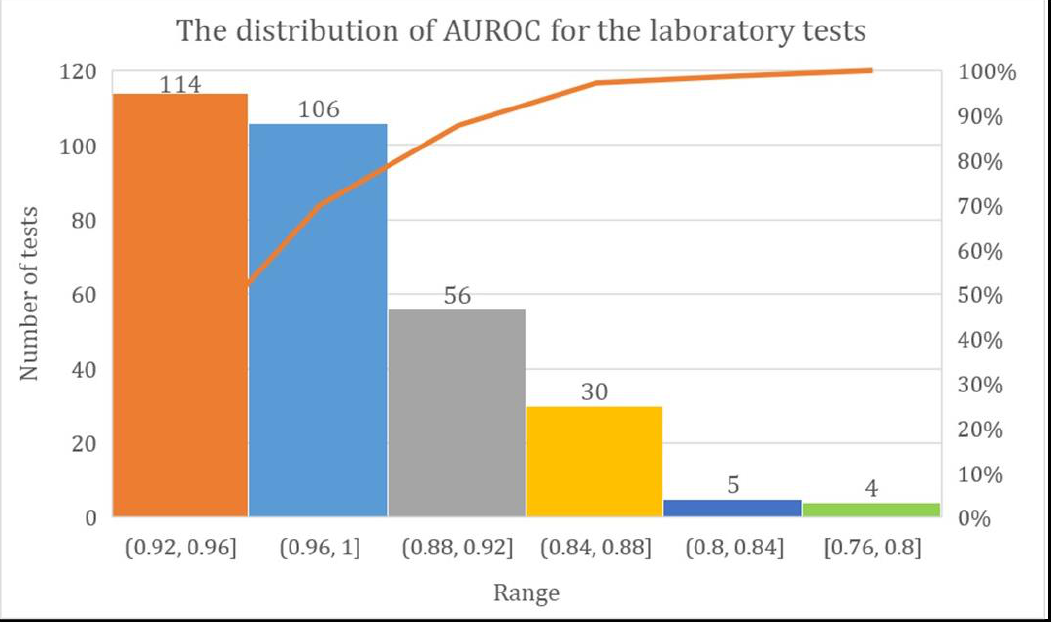
Figure 7. Total number of laboratory tests with their AUROC range.